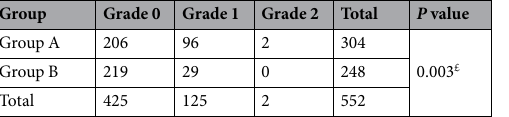
Table 4. Comparison of the malposition of screws using CT photographs according to Hojo’s method. £ P < 0.05 compared to the data of Group